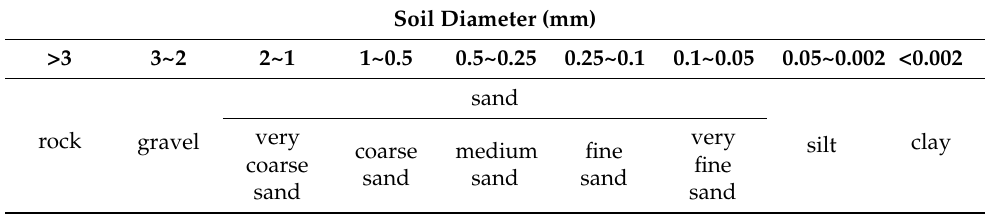
Table 1. Soil texture classification standard of soil texture